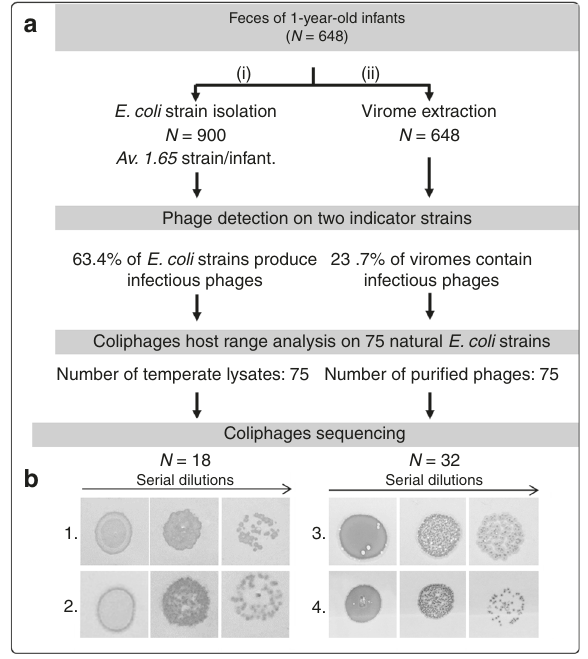
Fig. 1 Coliphages from 1-year-old infant fecal microbiota: overview of the study. a Fecal samples from 648 1-year -old infants were collected and used (i) to isolate E. coli strains and (ii) to extract their viromes. Next, two laboratory strains were chosen to culture coliphages from these two sources. Subsequently, using a subset of 75 coliphages from each source, the host-range was determined based on 75 E. coli isolates from the same cohort. Finally, the genomes of 18 temperate coliphages isolated from E. coli strains and 32 coliphages isolated in viromes were sequenced. b Examples of temperate/virulent phenotypes of the coliphages isolated from viromes. Various dilutions of coliphages ampli fi ed on either of the two indicator strains were spotted on soft agar plates inoculated with an E. coli indicator strain. Con fl uent growth and isolated plaques of two phages making turbid (1 and 2) and clear (3 and 4) plaques are